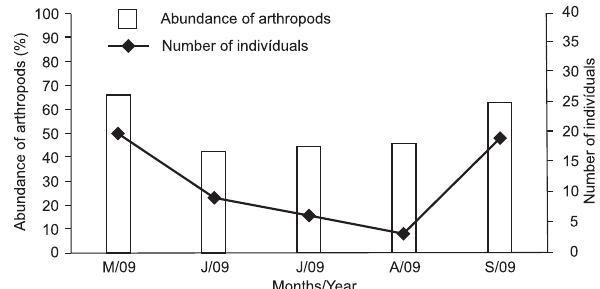
Figure 5. Arthropod abundance (Coleoptera, Orthoptera, Hy- menoptera, Diplopoda) in the diet and the relationship of it with the amount Monodelphis glirina